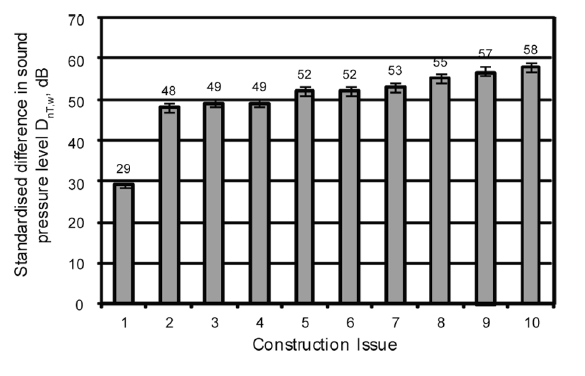
Fig. 12. Results of the standardised difference in sound pressure level D nT,w of structures